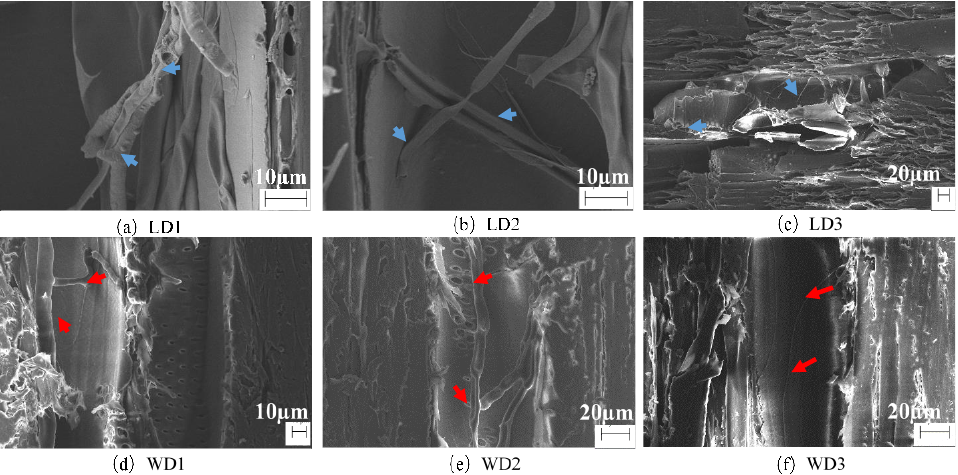
Figure 4. Micromorphology of vertical ( a – c ) and horizontal dyeing ( d – f ) of poplar wood by Lasiodiplodia theobromae after 40 days. (The arrow indicates the position of mycelium).